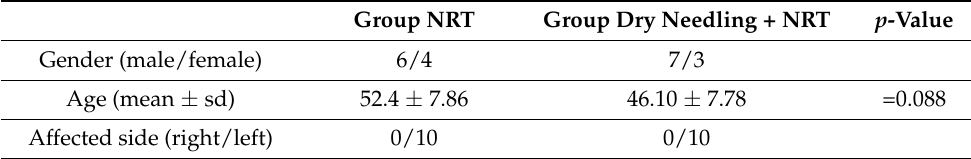
Figure 2. Consort 2010 flow diagram. Table 1. Baseline clinical, demographics and functional scales.